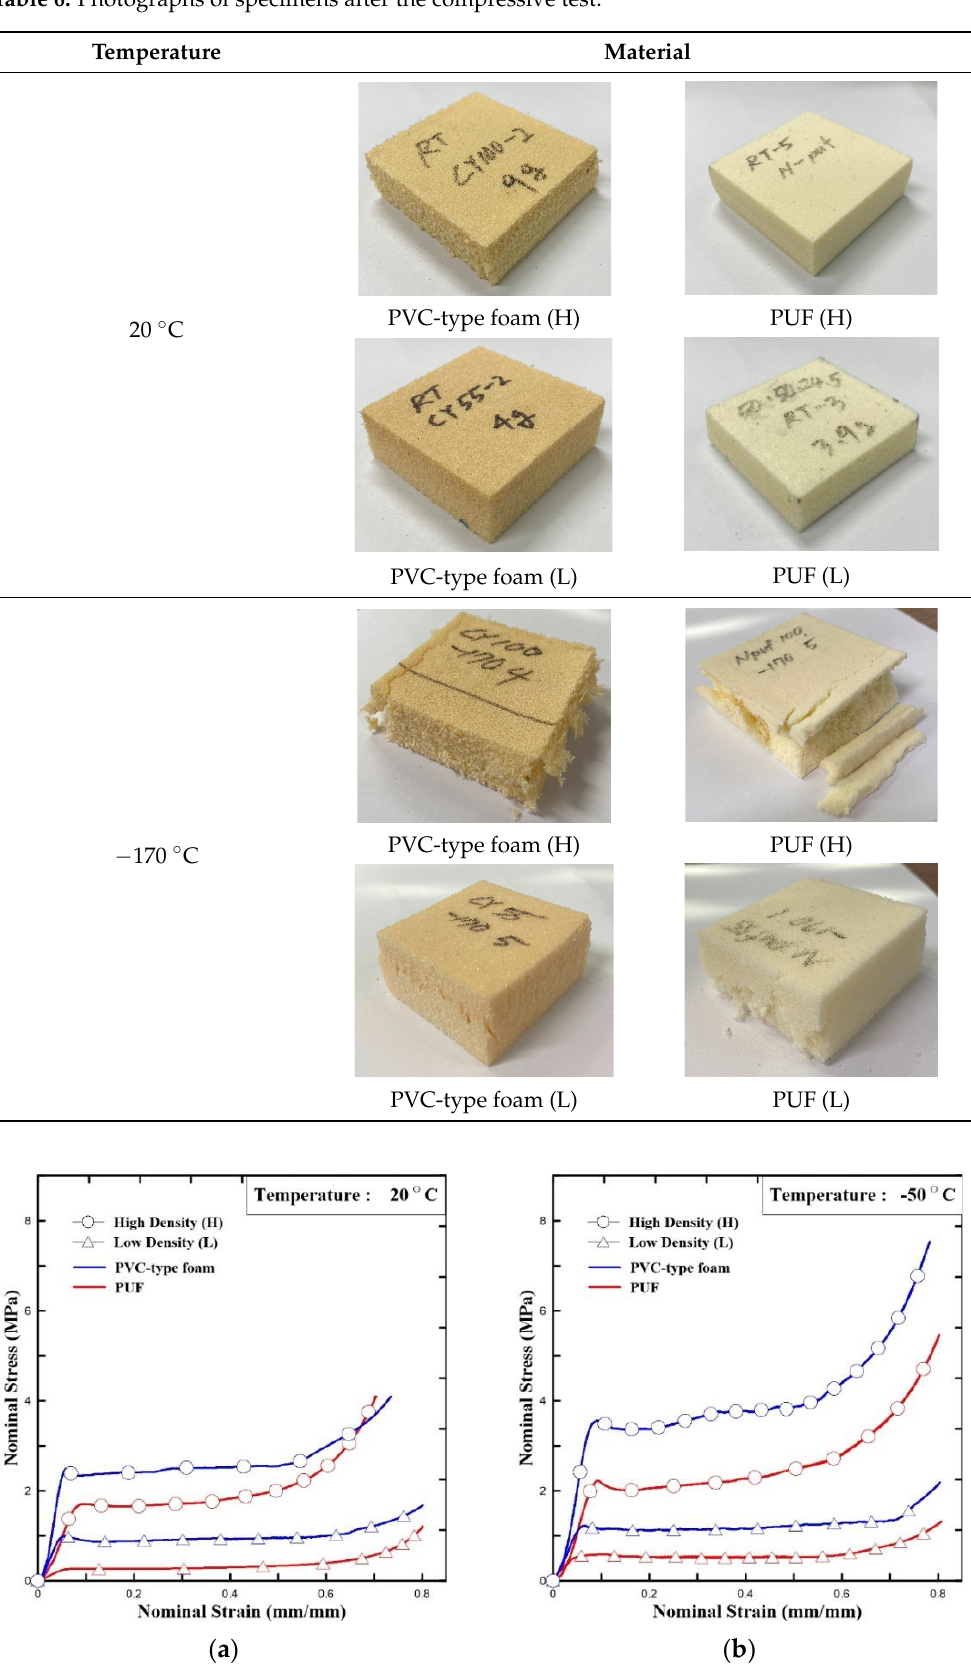
( d ) Figure 10. Stress – strain curve of the PUF(H, L) and PVC-type foam(H, L) at different temperatures: ( a ) 20 °C, ( b ) −50 °C, ( c ) −110 °C, and ( d ) −170 °C (compressive test). The four foam specimens exhibited better compressive performance at low tempera- tures than at room temperature, which is in line with the results of previous studies [46]. Therefore, in Figure 10, the compressive strengths and elastic modulus of PUF and PVC- type foam increase as the temperature decreases. Subsequently, as observed in Figure 10, PVC-type foam had a higher compressive strength than neat PUF. Further, the gap be- tween PVC-type foam and PUF with a similar density tended to narrow as the tempera- ture decreased. The linear slope at the beginning of the graph is called the elastic modulus, and the elastic modulus of the PVC-type foam is generally larger than the PUF at all tem- peratures. The average compressive strength was also greater than that of the PUF having the same density. These results are confirmed not only by Figure 10 but also by Table 7, highlighting the average values of the test results. Compressive yield stresses of the PUF were enhanced by approximately 150% at cryogenic temperatures than at room tempera- ture. Likewise, the compressive elastic modulus also increased by approximately 100%. Yield stresses of the PVC-type foam increased by approximately 70% at cryogenic tem- peratures for low densities. Similarly, the compressive elastic modulus also increased by approximately 100%.